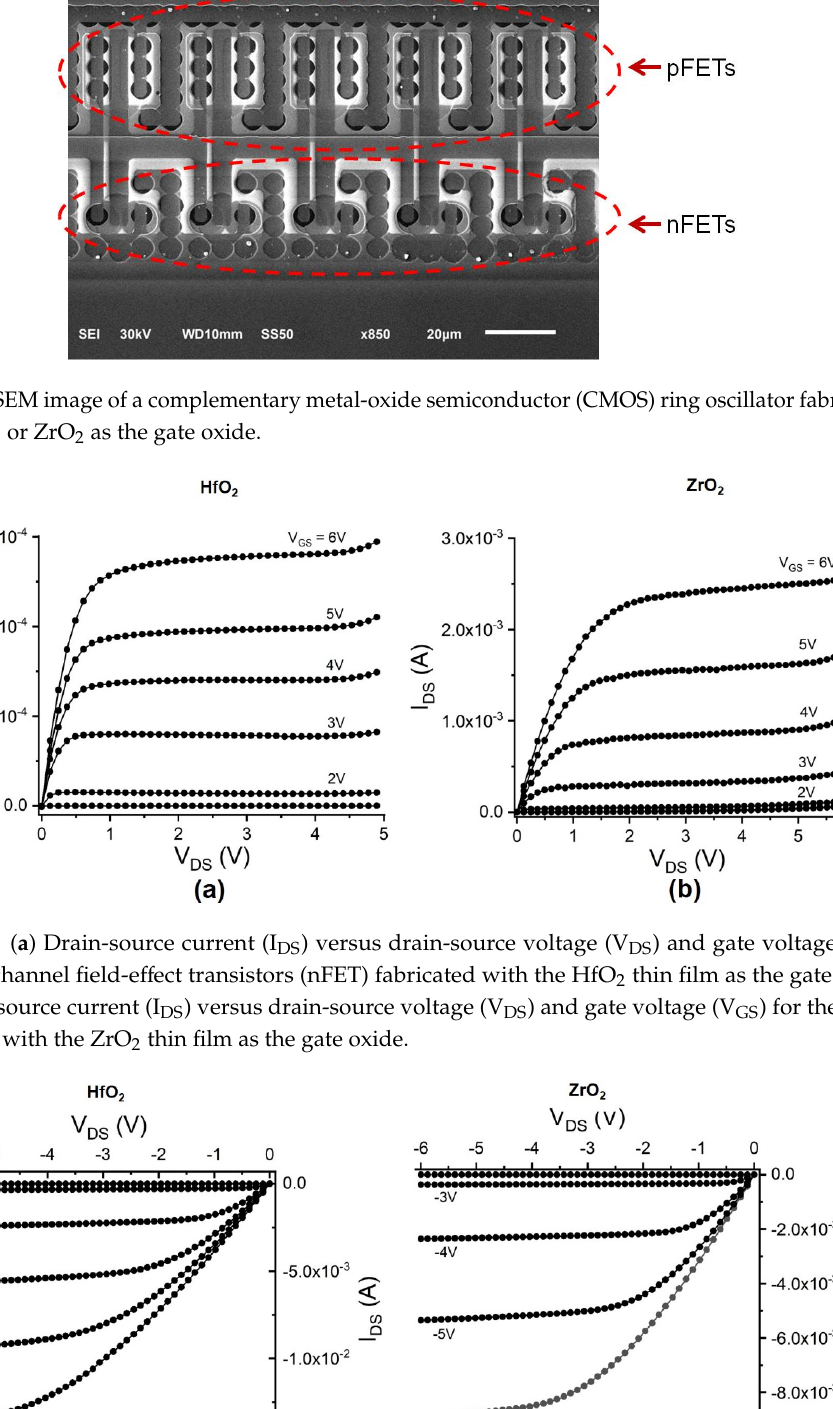
Figure 8. Refractive index and extinction coefficient of the HfO 2 and ZrO 2 thin films versus wavelength.